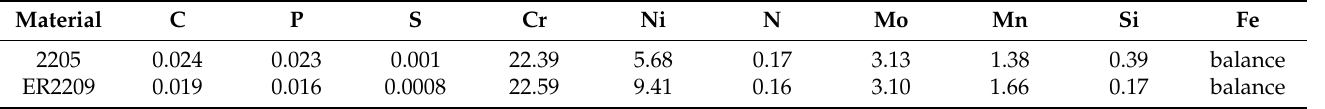
Table 1. Main chemical composition of DSS2205 and ER2209